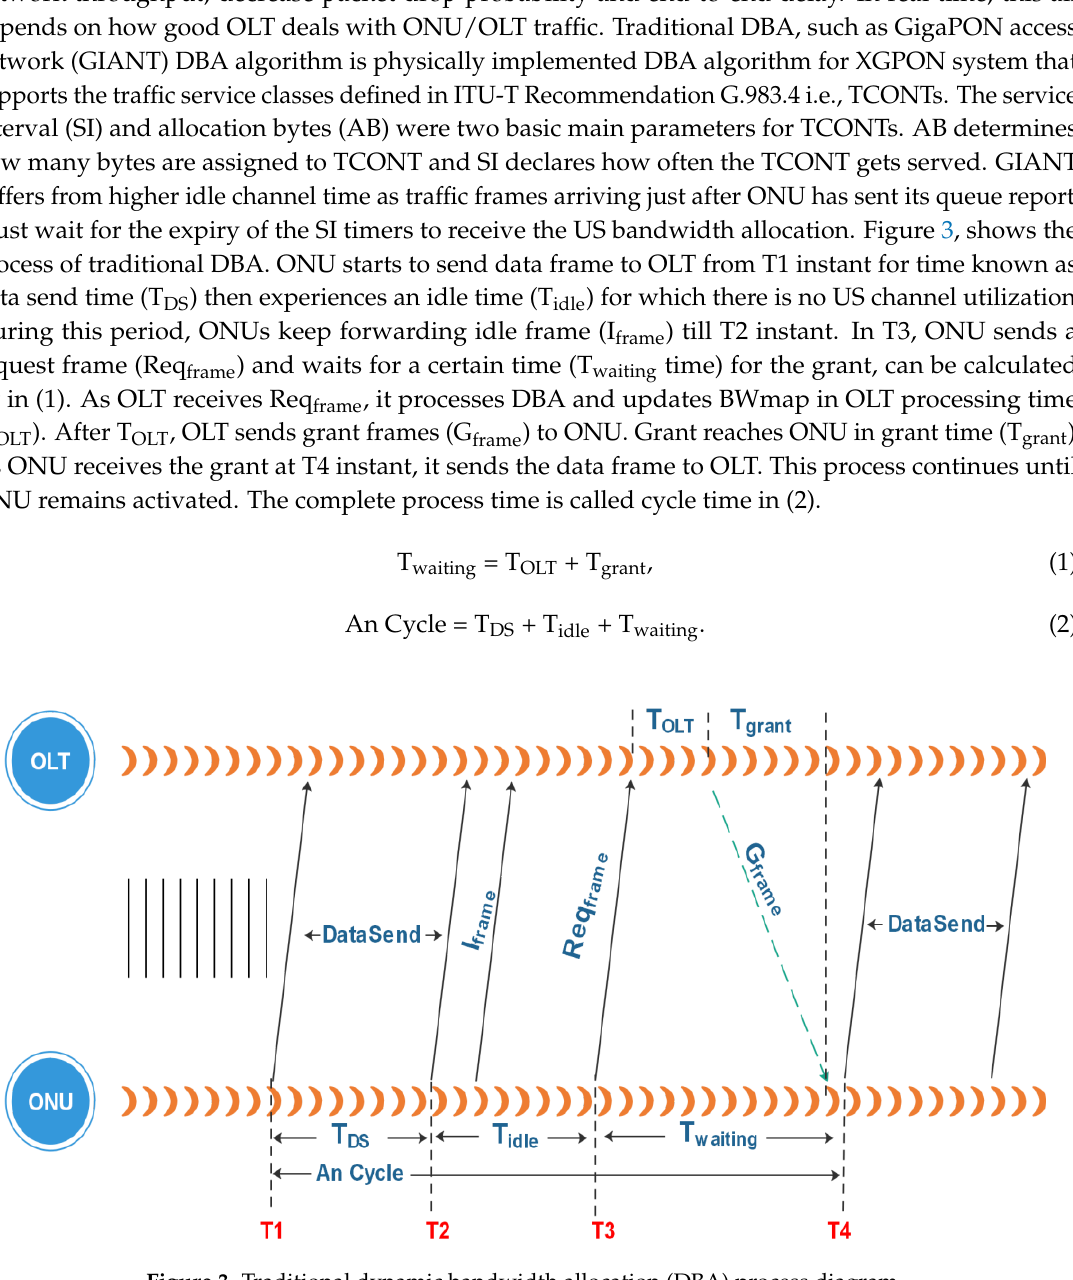
Figure 3. Traditional dynamic bandwidth allocation (DBA) process diagram.